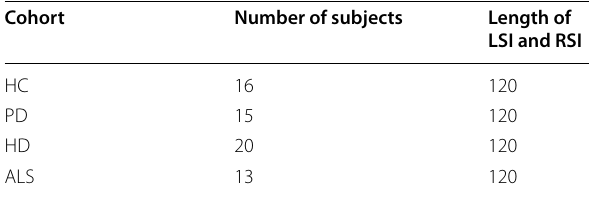
Table 2 Gait in neurodegenerative disease data Cohort Number of